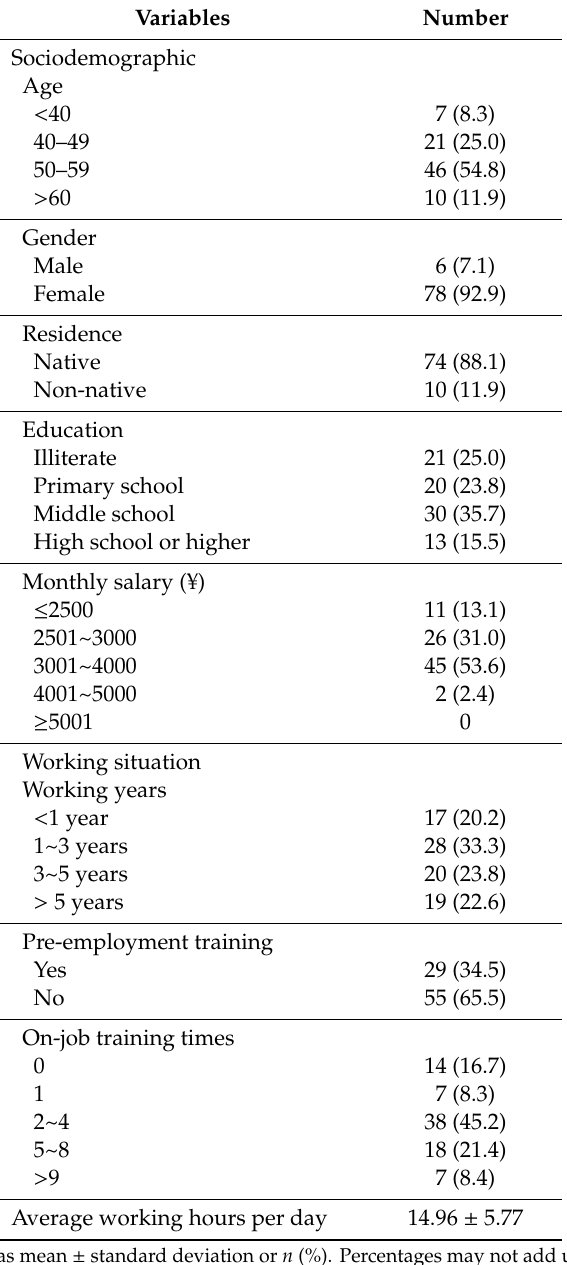
Table 1. Socio-demographic characteristics of respondents ( n =